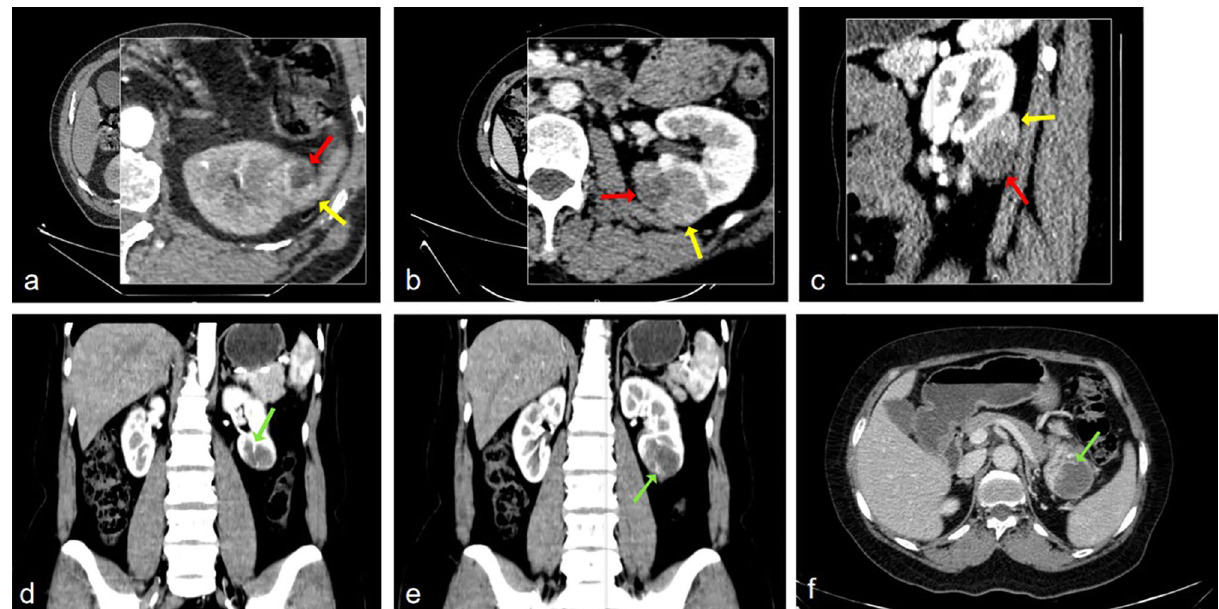
Figure 3. ( a , b , c ) Postcontrast CT: cystic (red arrow) and solid (yellow arrow) components of unilocular cystic clear cell RCC. ( e , f , g ) irregular internal structures (green arrow) in the unilocular cystic papillary RCC.